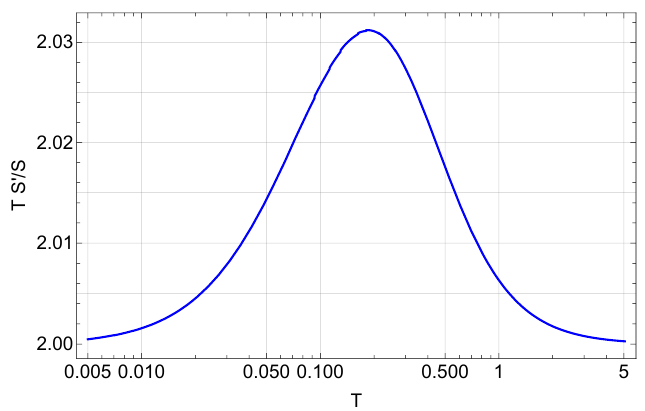
Figure 1 . Plot of the logarithmic derivative of the entropy TS 0 ( T ) /S ( T ) as a function of the temperature indicating that our solutions interpolate between two AdS 4 geometries. Here φ and c = 1